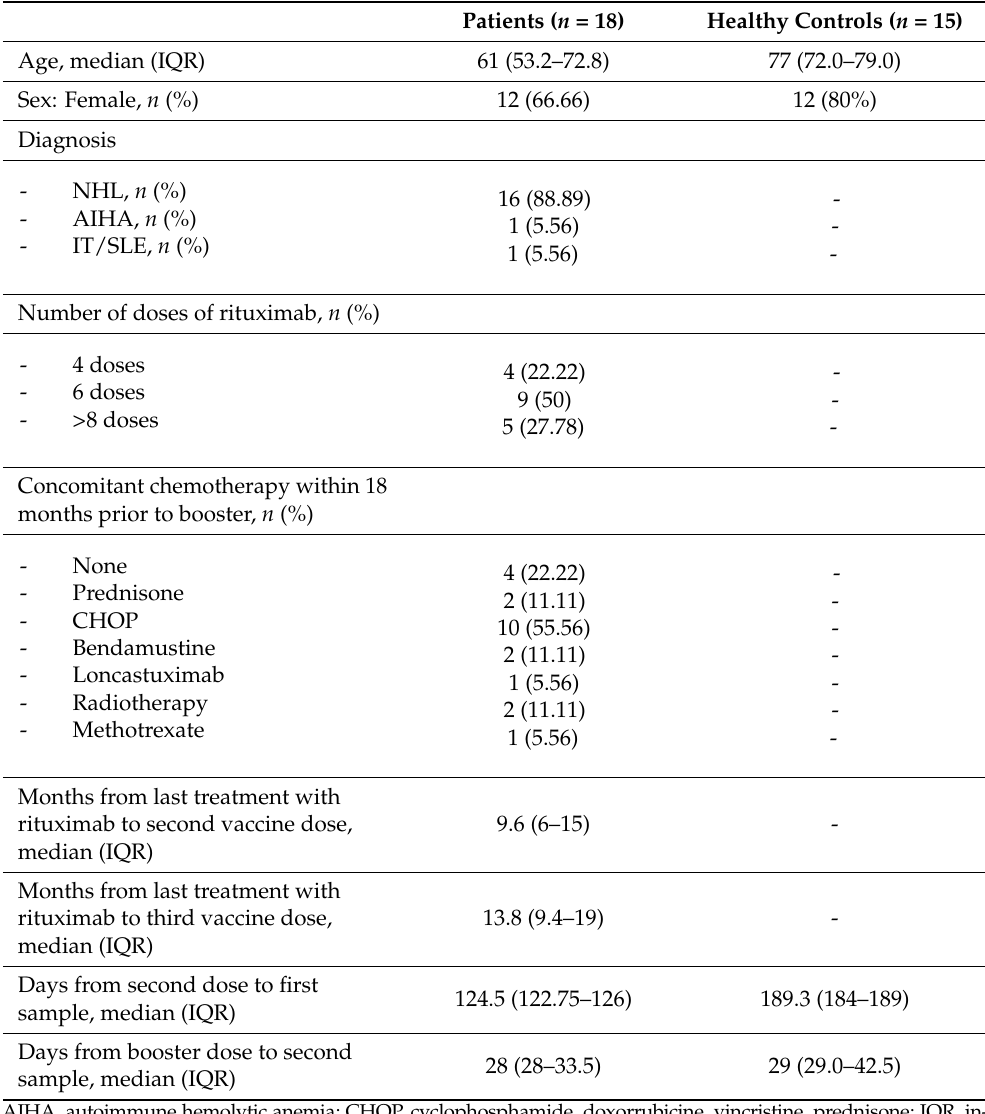
Table 1. Baseline sociodemographic and clinical characteristics of the individuals with hematological disease who were recruited for this